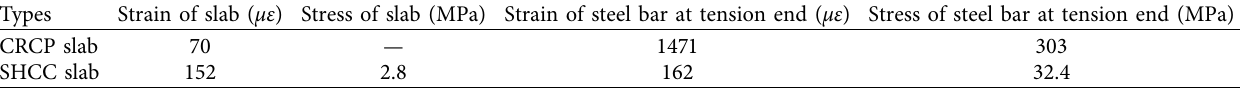
Table 8: Comparison of internal force between CRCP slab [18] and SHCC